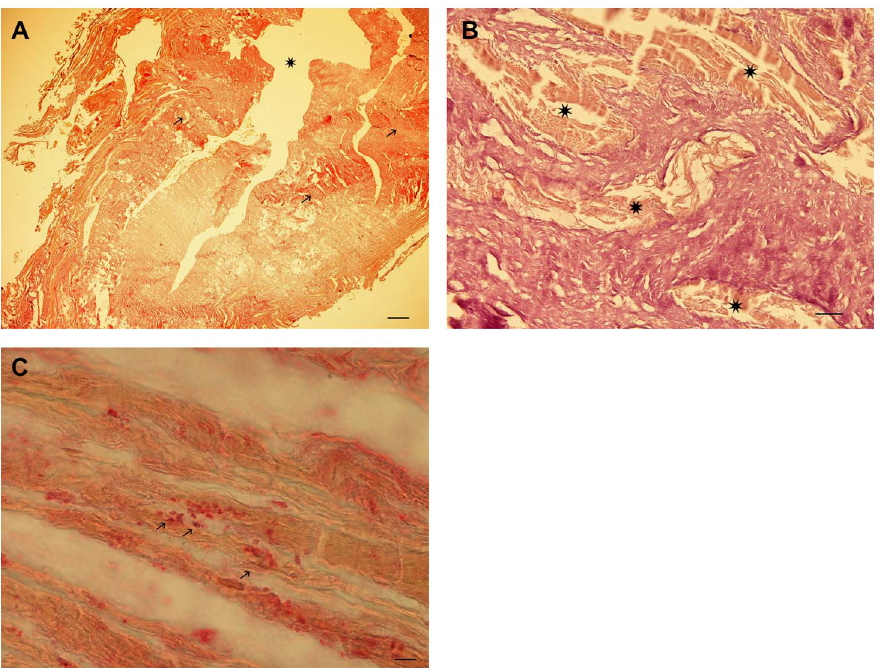
Figure 7. Histology of the rectal wall sample. ( A ) Overview of the specimen showing the lumen of the rectum (asterisk) which is surrounded by the rectal wall with a typical ring-like smooth muscle (arrows). (Haematoxilin and eosin, bar 500 m m). ( B ) A detailed view of the rectal wall (connective tissue stain) shows smooth musculature (asterisks) which is interspersed by broad bundles of collagen providing the clear diagnosis of massive fibrosis. (Van Gieson connective tissue stain, bar 100 m m). ( C ) Immunohistochemical staining with a monospecific antibody against Trypanosoma cruzi showing a positive immunostaining of small corpuscular inclusions in smooth muscle cells (arrows). (anti- Trypanosoma cruzi , APAAP-staining, bar 10 m m). doi:10.1371/journal.pone.0089528.g007 muscle wall up to 1.2 cm on the left heart. Inside the heart dried blood was visible as a longish hyperdense structure (Figures 5A, B).